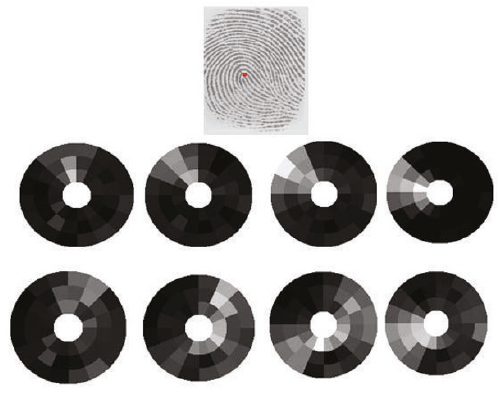
Figure 5: A fingerprint and its extracted FingerCode features around the core point.